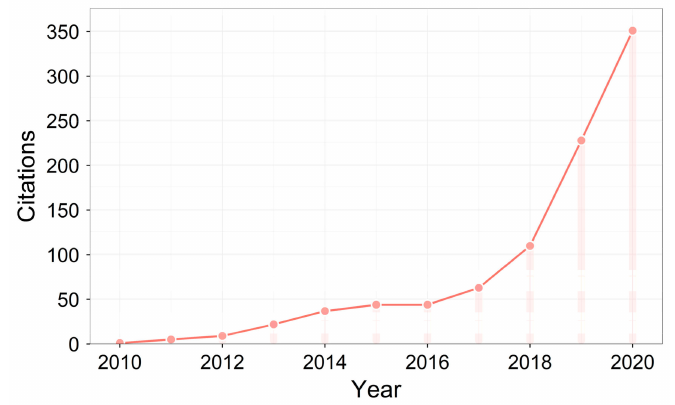
Figure 2. The variations in the number of citations from 2010 to